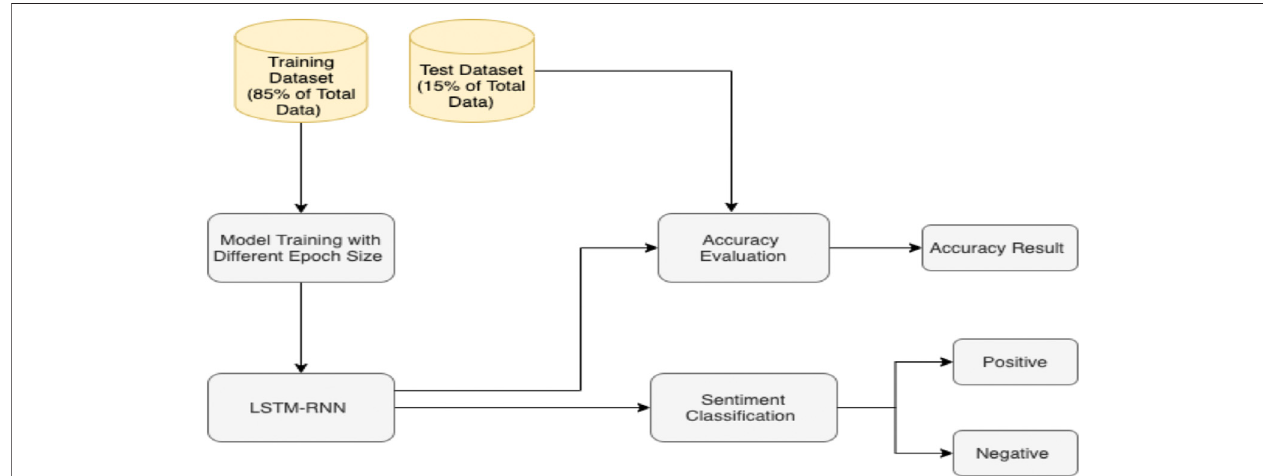
FIGURE 8 | Architecture of LSTM result.